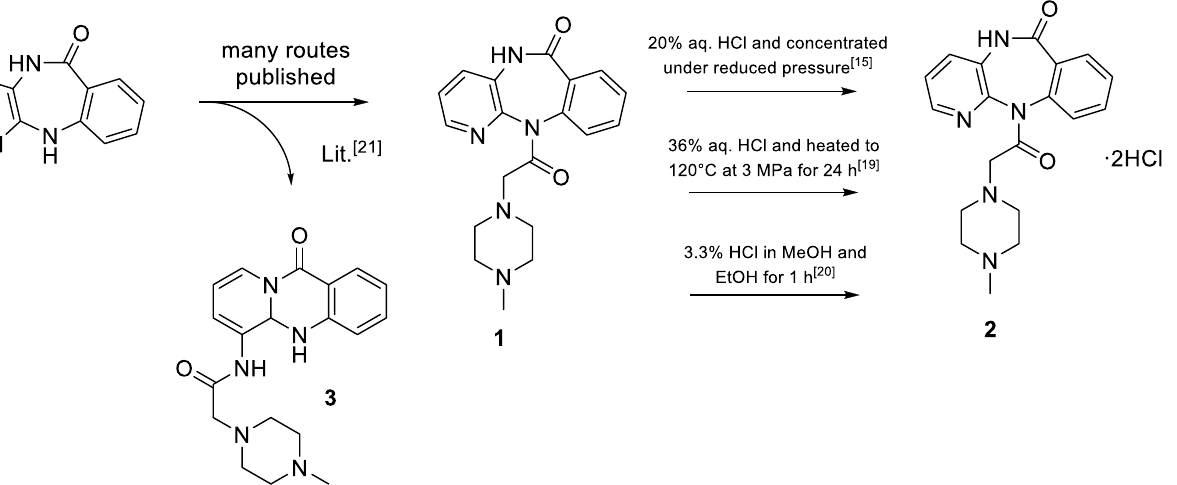
Figure 1. Overview of synthetic routes of pirenzepine dihydrochloride. Emphasis is given on the synthetic conditions for the formation of the